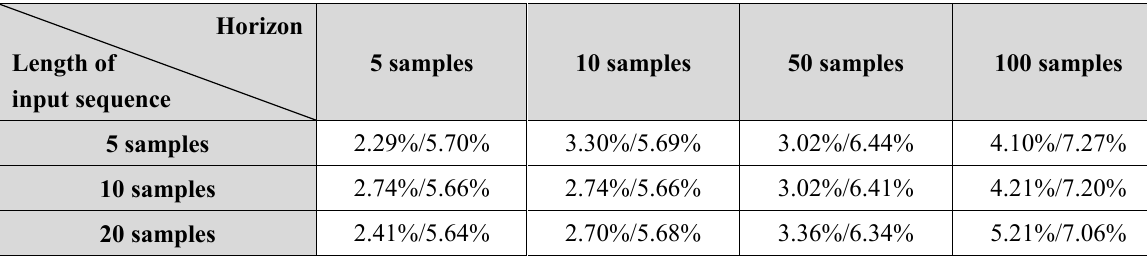
Table 4. Data prediction results (% error ANN/% error interpolation) for temperature in Sensor 3, using temperature in Sensor 1 as an